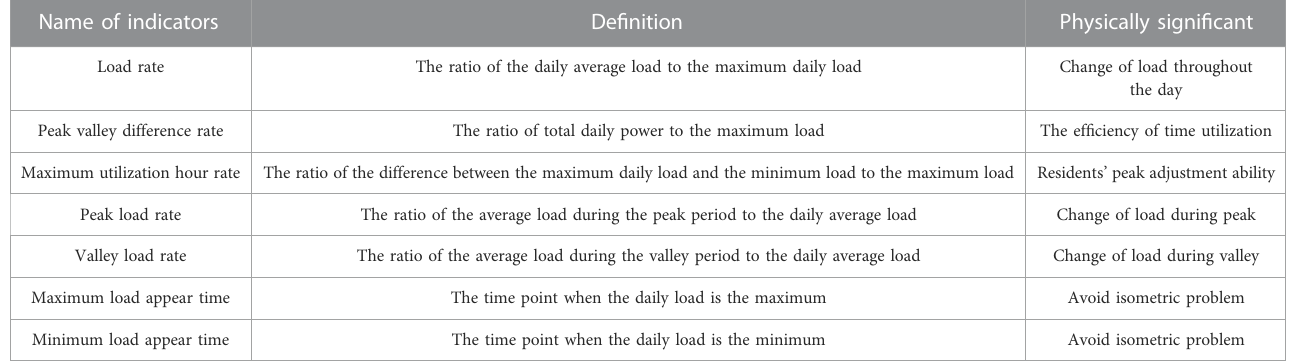
TABLE 1 Characteristic indicators based on daily load